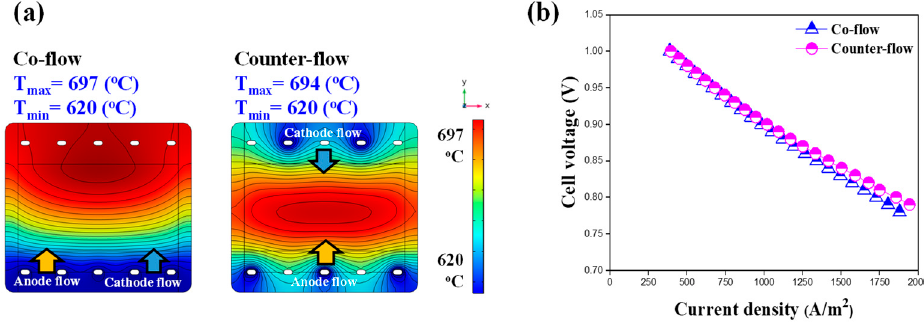
Figure 8. ( a ) Temperature distribution and ( b ) i–V curve, according to the flow direction.